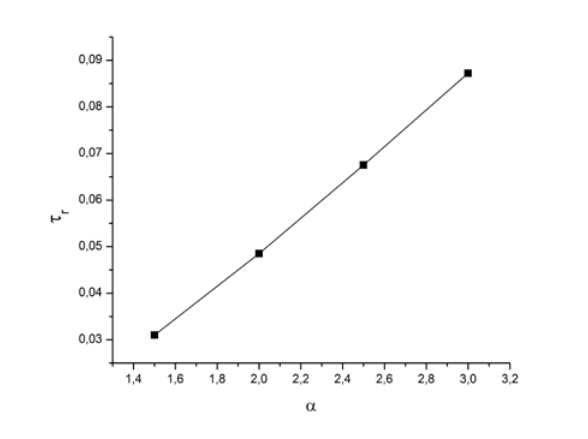
Fig. 6. Dependence of retention time τ r on α